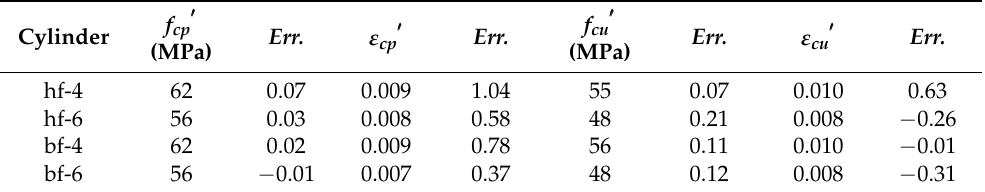
Table 6. Evaluation of Wu’s model [33] for predicting the performances of cylinders with strain- softening